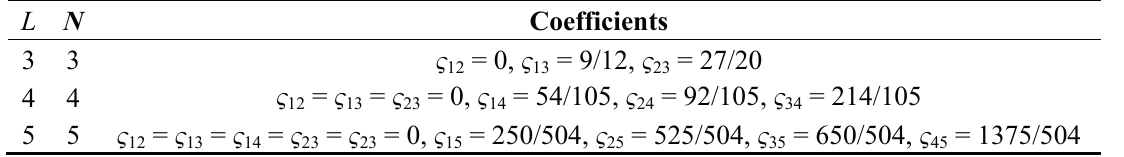
Table 5. Coefficients expanded from the FTSc coefficients in Table 1.